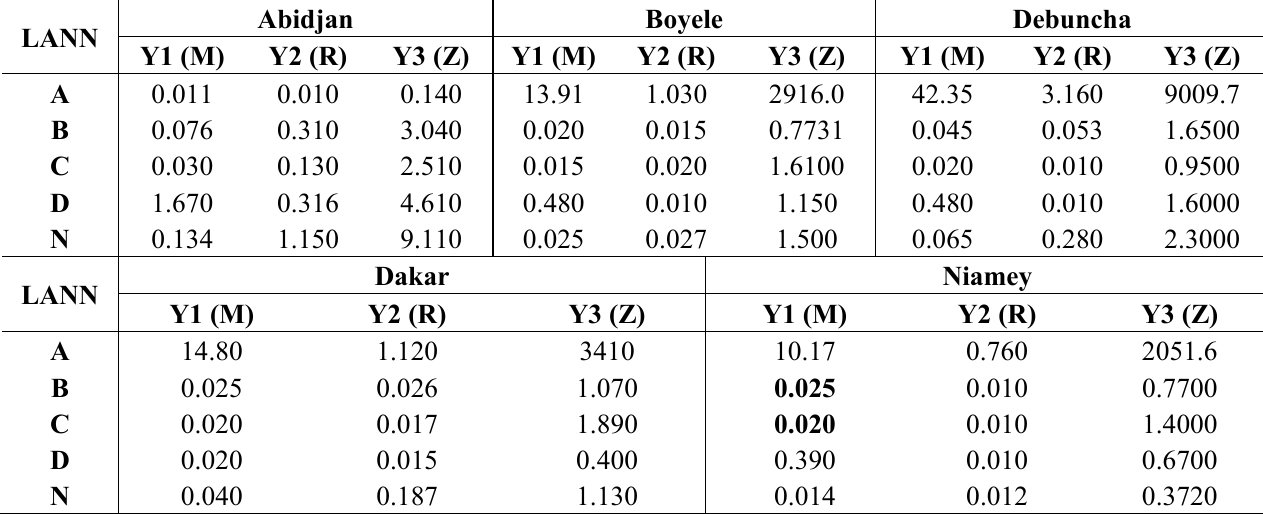
Table 9. Comparisons between RMSE after using the different LANN: Case of the convective